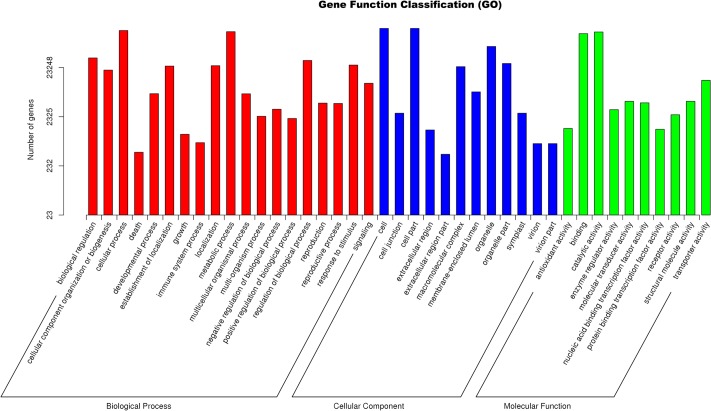
Functional classification of Gene Ontology (GO) for assemble unigenes of S. alopecuroides.A total of 23,248 unigenes were assigned into 41 functional groups of three categories.